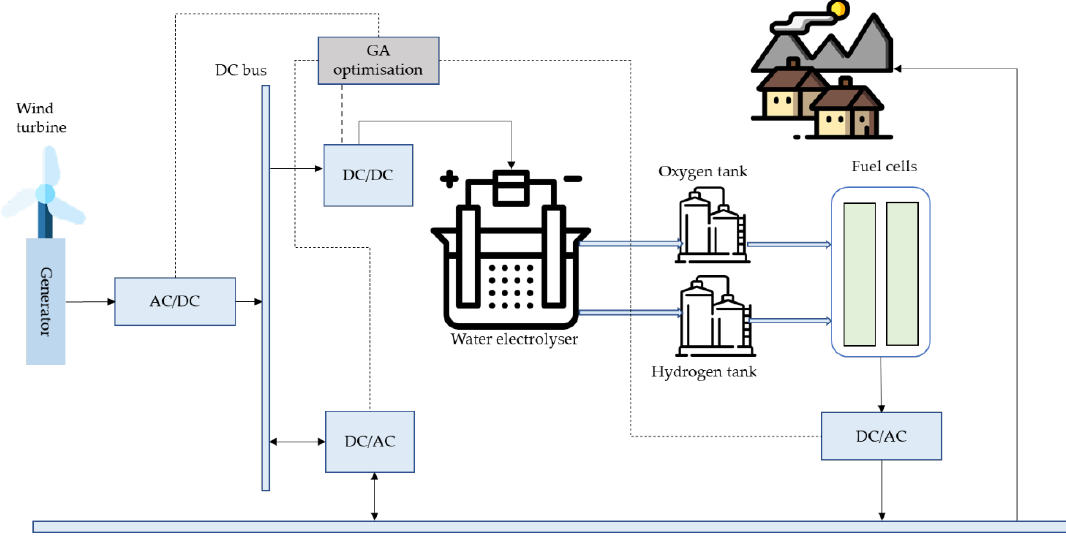
Figure 1. Schematic diagram of the proposed system.